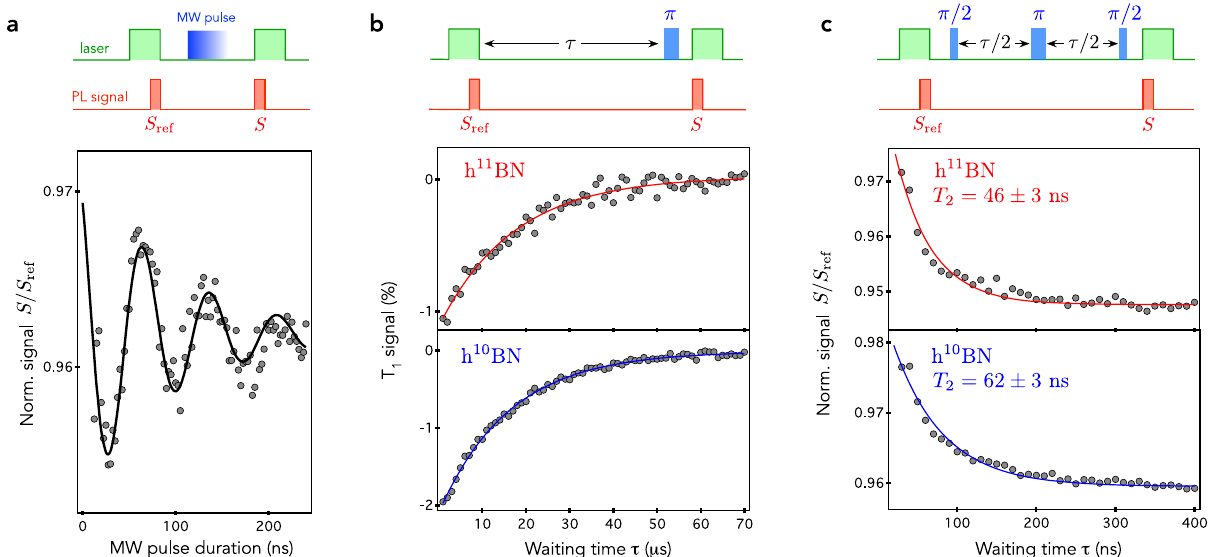
spin defects recorded by applying the experimental sequence Fig. 3 Spin coherence properties. a Optically detected Rabi oscillations of an ensemble of V (cid:1) B shown in the top panel. The spin-dependent PL signal S is integrated at the beginning of the readout laser pulse and normalized by a reference signal S ref , which corresponds to the steady-state PL signal measured at the end of the initialization laser pulse. b T 1 measurements in the two monoisotopic crystals. Here we plot the difference of the normalized PL signal S / S ref measured with and without applying the resonant microwave π -pulse (see top panel). Solid lines are data fi tting with an exponential decay, leading to T 1 ~ 16 μ s in both samples. c Measurement of the spin coherence time T 2 using a spin echo pulse sequence. Solid lines are data fi tting with an exponential decay. All experiments are performed with a static magnetic fi eld B ~ 15 mT applied along the c axis. The duration of the laser pulses is 8 μ s with a power of 1 mW and the integration time window of S and S ref is fi xed to 300 ns. The duration of the microwave π /2 pulse is set to 15